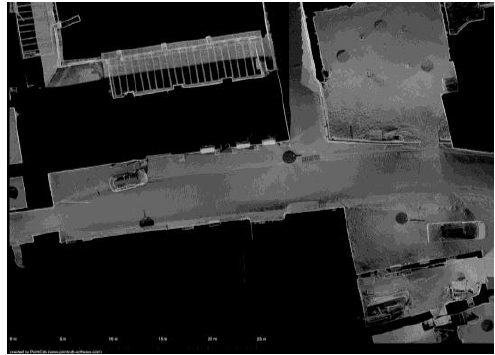
Figure 3. Orthoimage of the location of the nave Using GIS gives us the possibility to compare the existing remains with the location of buildings in the plans and maps created between the 17 th and the 19 th century. For example, the georeferenced map of the figure 4 dates back to 1674 (Paris, Archives nationales, CPNIII_Indre-et-Loire), when St Maur Congregation tried to renovate monastic life by modifying the spatial organization of the monastery.